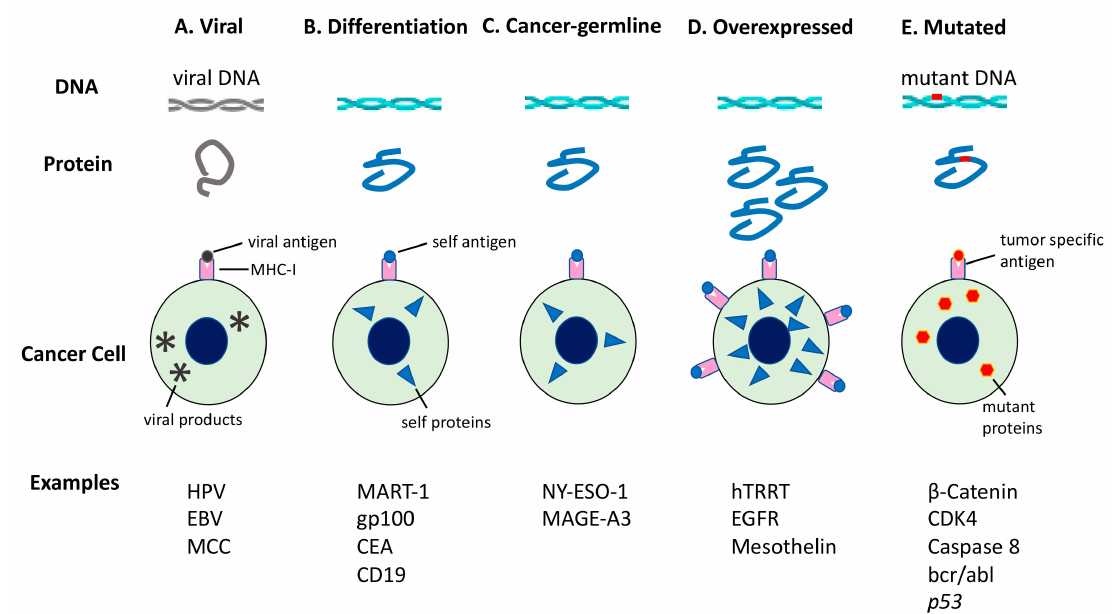
Figure 3. Tumor antigens recognized by immune cells. Tumor antigens are classified in accordance with the pattern of gene expression. The production of antigenic peptides by cancer cells is shown herein. Viral antigens are only expressed in virus-infected cells. Di ff erentiation antigens are encoded by genes with tissue-specific expression. Cancer germline genes are expressed in tumors or germ cells owing to whole-genome demethylation. Some genes are overexpressed in tumors owing to increased transcription or gene amplification. The resulting peptides are upregulated on these tumors but also show a low level of expression in some healthy tissues. However, mutated genes may yield a mutant peptide (neoantigen), which is recognized as non-self by immune cells. CEA, carcinoembryonic Ag; EGFR, epidermal growth factor receptor; EBV, Epstein-Barr virus; HPV, human papillomavirus; hTERT, human telomerase reverse transcriptase; MAGE-A3, melanoma-associated antigen 3; MART-1, melanoma antigen recognized by T cells-1; MCC, Merkel cell